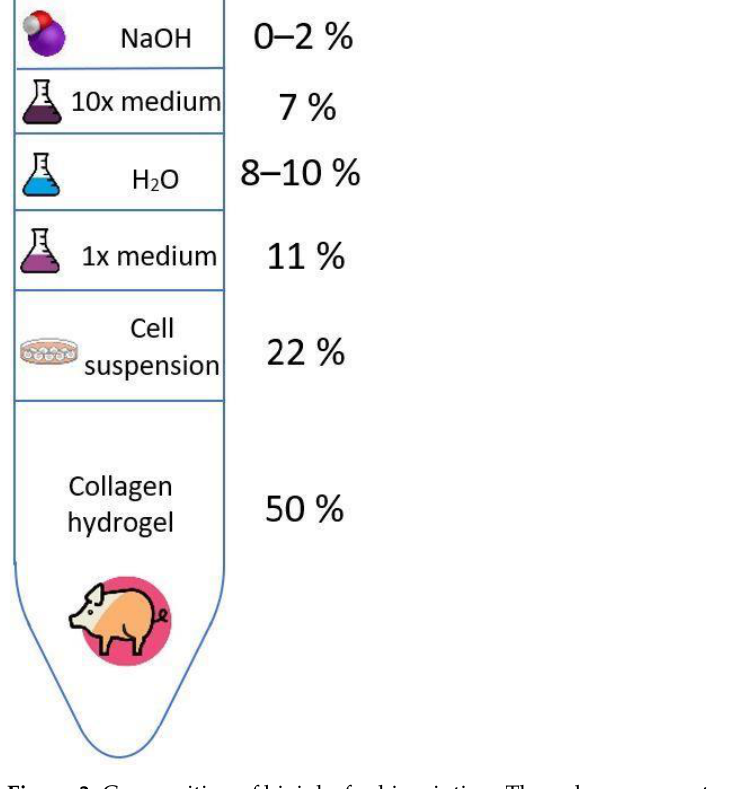
Figure 3. Composition of bioinks for bioprinting. The volume concentration of the 1 molar NaOH solution was varied to achieve different pH values. The water volume was then chosen so that the resulting bioink volume was always identical. More details are described in the text.